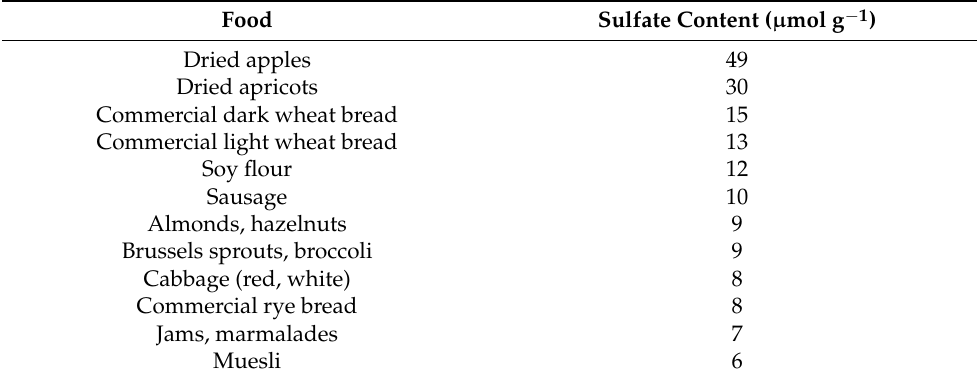
Table 3. Selected foods with high sulfate content, sorted in descending order (modified from Florin et al.